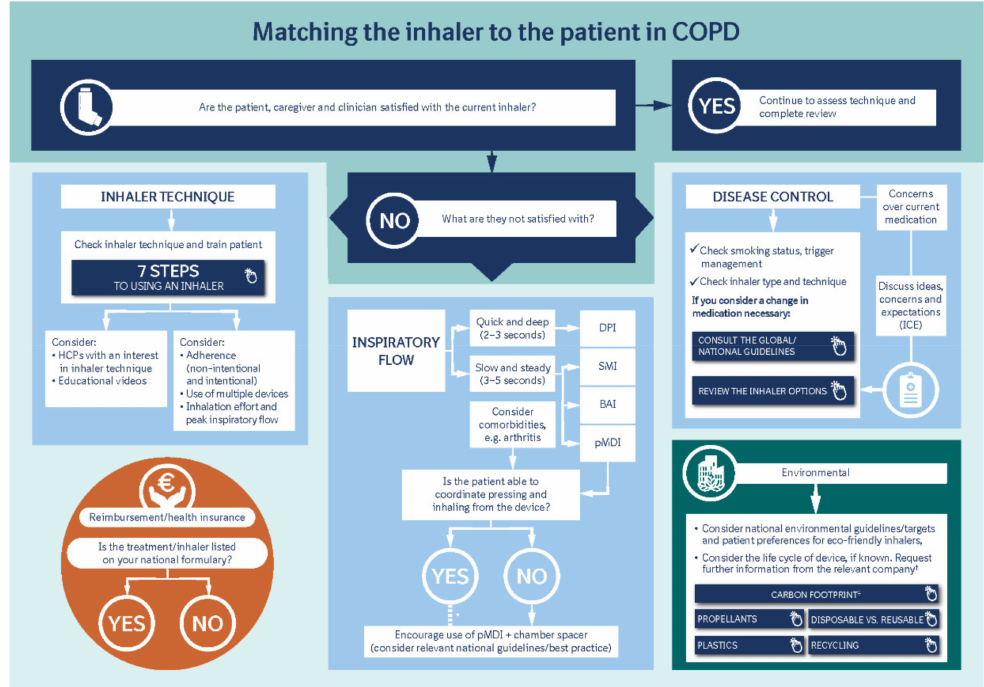
Figure 1. Matching the inhaler to the patient in COPD: † Take into account the influence of the pharmaceutical industry on sponsored research; ‡ Carbon footprint encompasses several elements throughout the product lifecycle, including manufacturing, propellants and plastic use/recycling. BAI, breath-actuated inhaler; DPI, dry powder inhaler; HCP, healthcare provider; ICE, ideas, concerns, and expectations; pMDI: pressurized metered-dose inhaler; SMI, soft mist inhaler. 7 Steps (https://www.respiratoryfutures.org.uk/media/69774/ukig-inhaler-standards-january-2017.pdf; accessed on